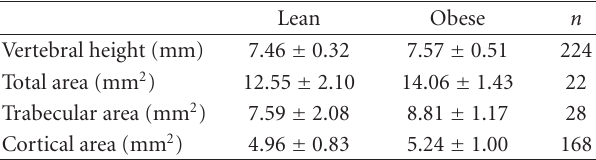
Table 4: L 6 geometrical